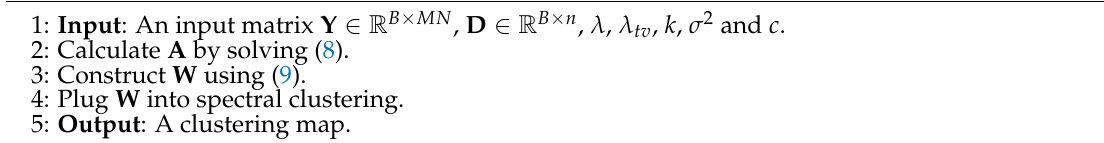
Algorithm 1 The complete procedure of the proposed Sketch-SSC-TV